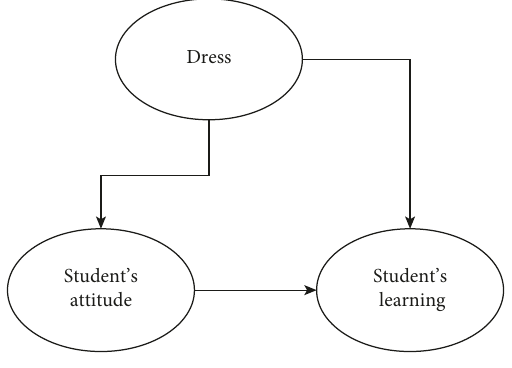
Figure 1: Theoretical model of the study.